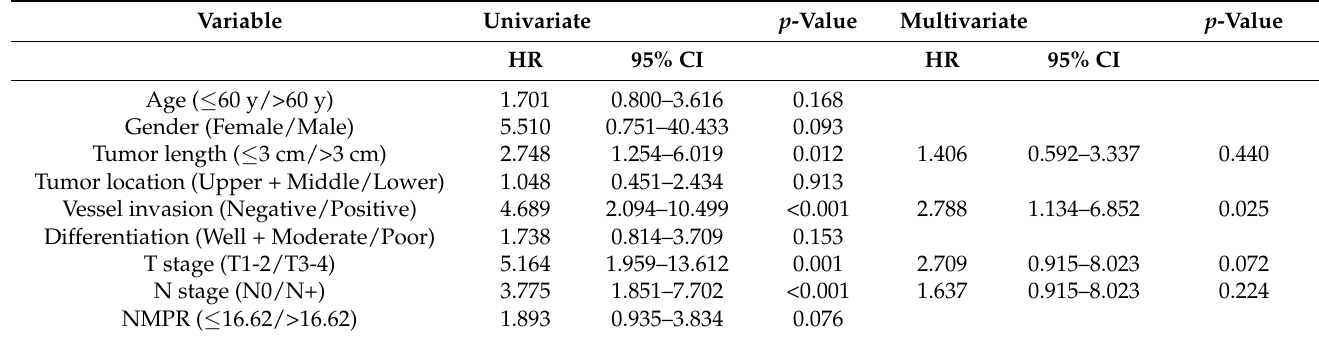
Table 4. Univariate and multivariate Cox regression analyses for progress-free survival in the external validation cohort (SY